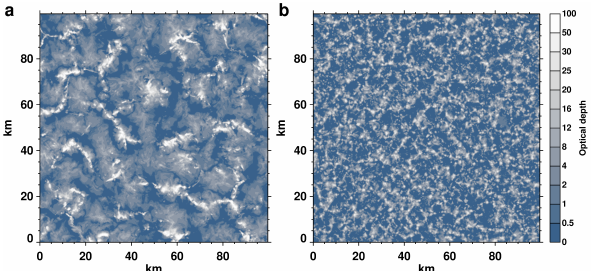
Fig. 12. Cloud optical depth in simulation S ⊗ after 12h (a) and 36h (b) .